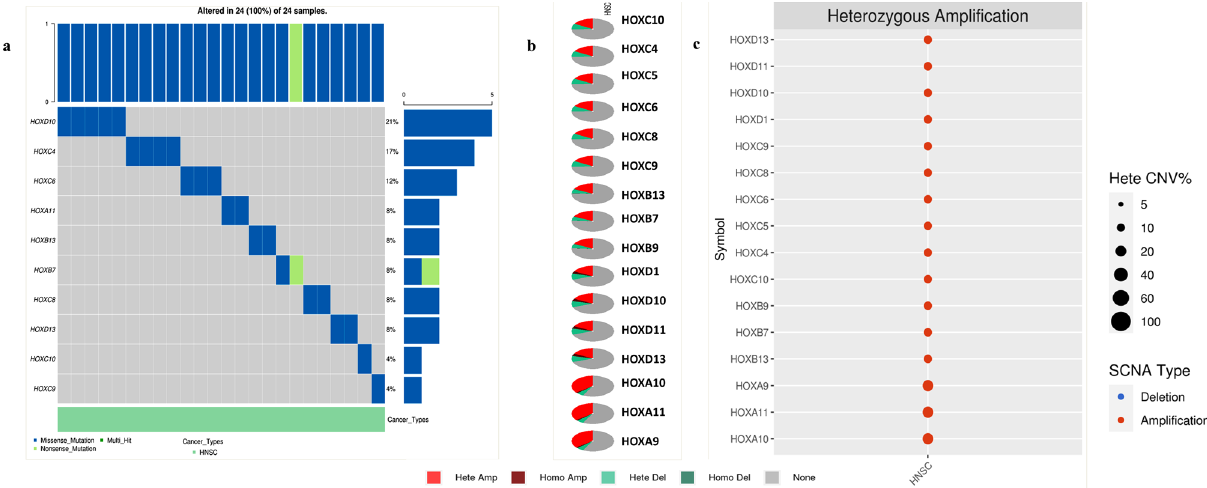
Figure 2. Differentially expressed HOX genes (DEHGs) and their genetic variation in HNSCC: ( a ) Single Nucleotide Variants (SNV): Oncoplot showing the top ten mutated genes in the HNSCC data set. The type of SNV is color-coded as shown in the figure. Bar plots on the side and top of the figure, show the number of variants in each sample and gene respectively. ( b ) Copy Number Variation (CNV): Pie chart represents the global profile that shows the proportion of heterozygous or homozygous CNV of each gene in HNSCC. c) CNV profile shows the percentage of heterozygous amplification, about each gene with > 5% CNV in HNSCC. Red color bubble intensity represents the positive correlation between higher gene expression levels and the high frequency of CNVs. The size of the point positively correlates with statistical